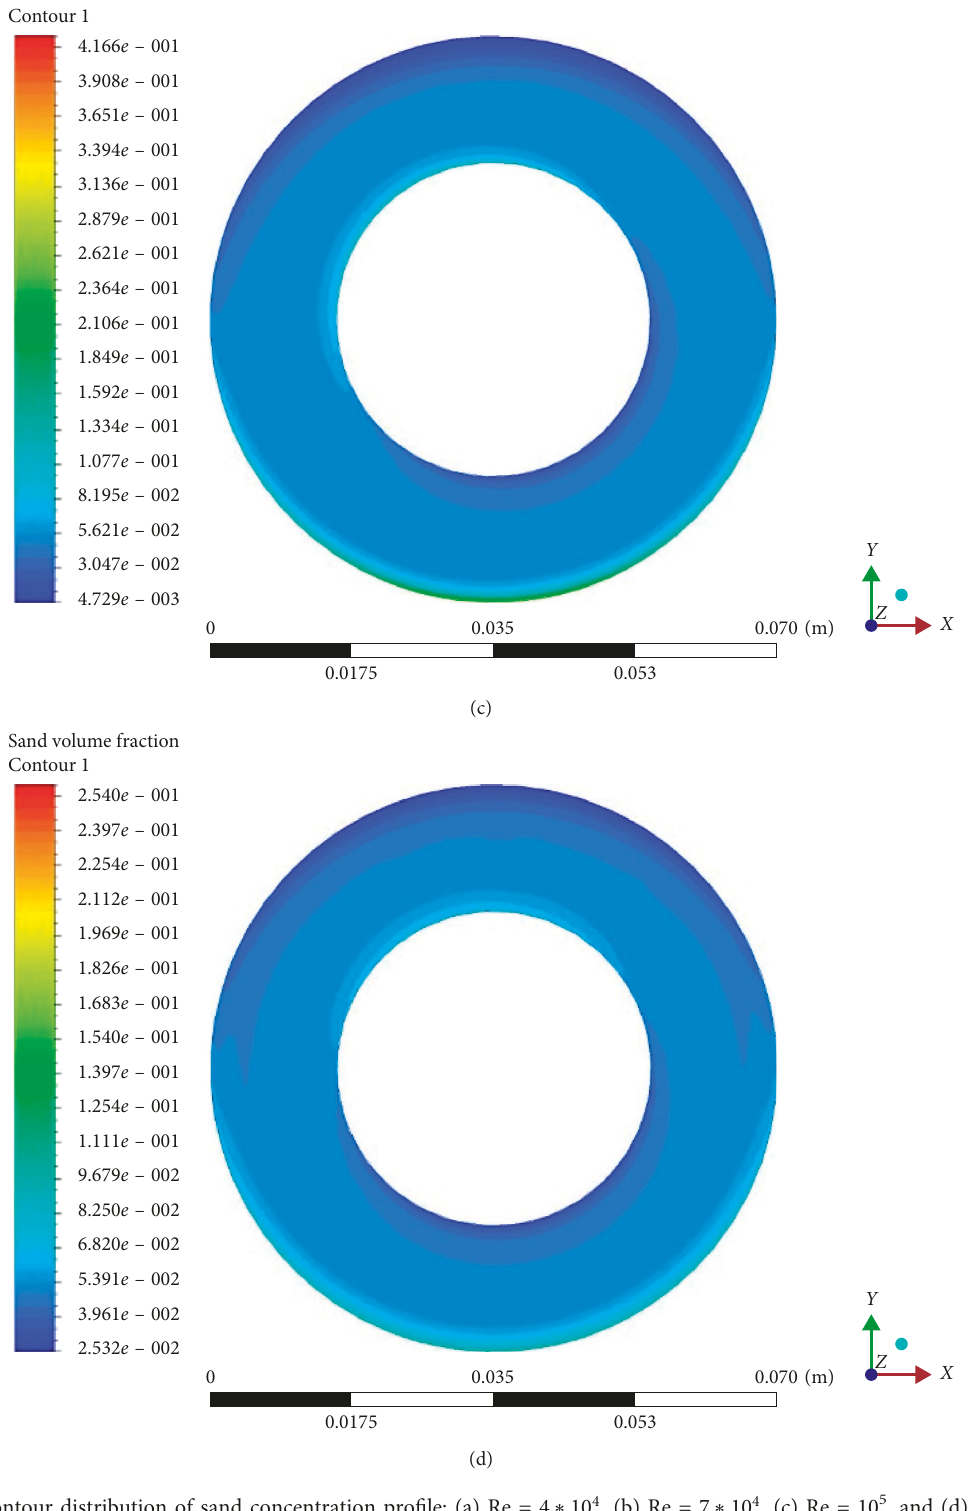
Figure 14: Contour distribution of sand concentration profile: (a) Re � 4 ∗ 10 4 , (b) Re � 7 ∗ 10 4 , (c) Re � 10 5 , and (d) Re � 2 ∗ 10 5